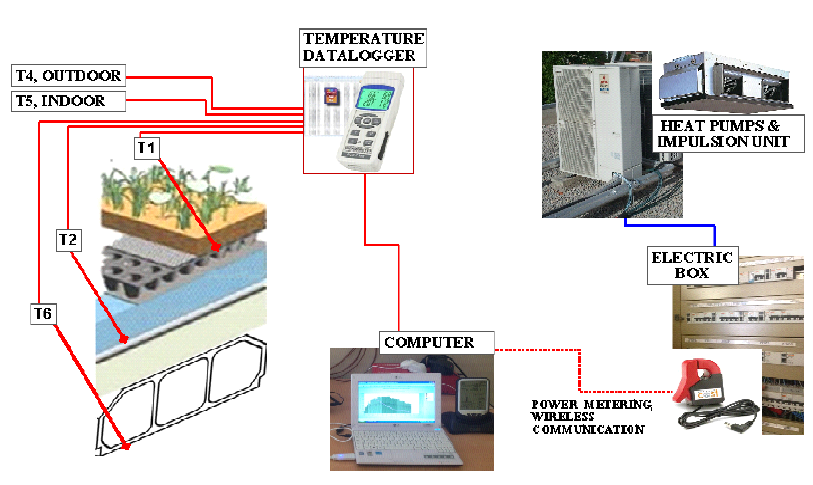
Figure 6. General view of greenroof.